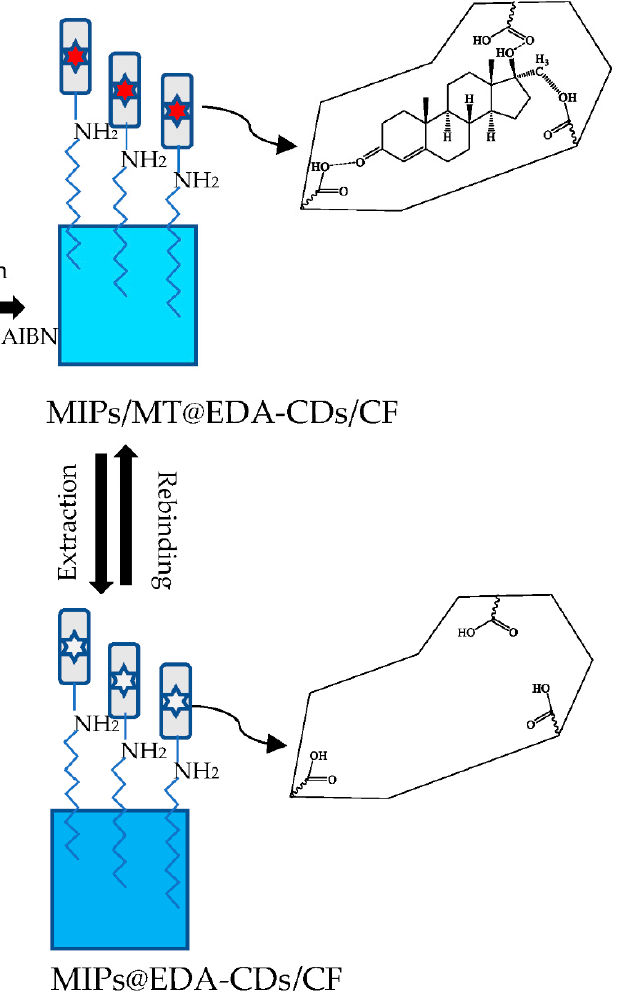
Figure 3. Scheme of polymerization of the MIPs@EDA-CDs/CF and extraction of the template mol-